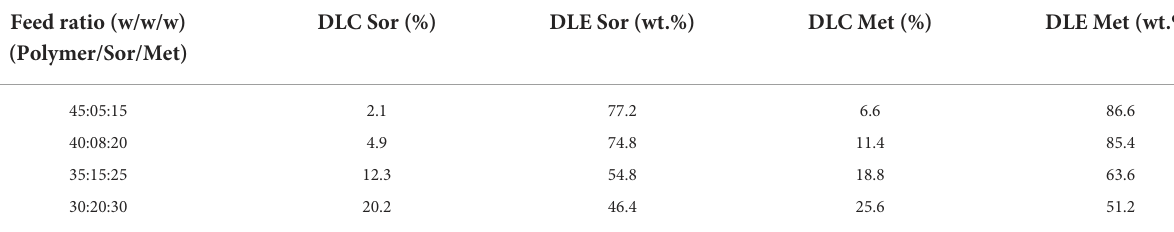
TABLE 1 DLC and DLE of Sor and Met of NSM. Feed ratio